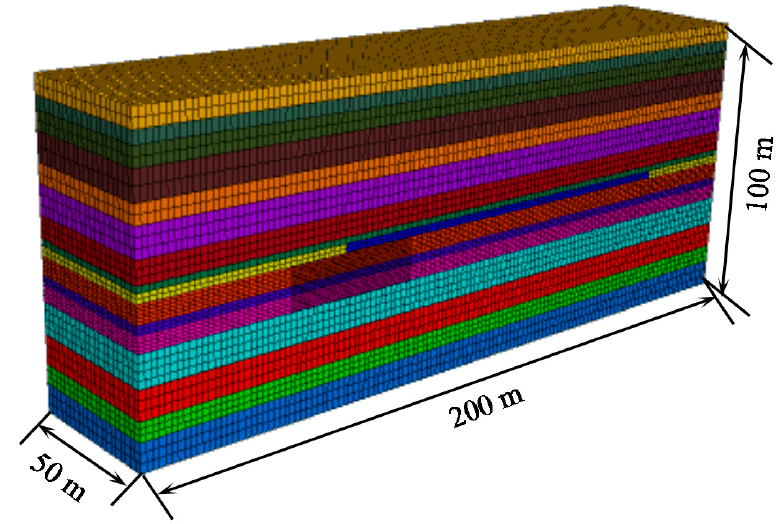
Figure 3. Numerical calculation model.